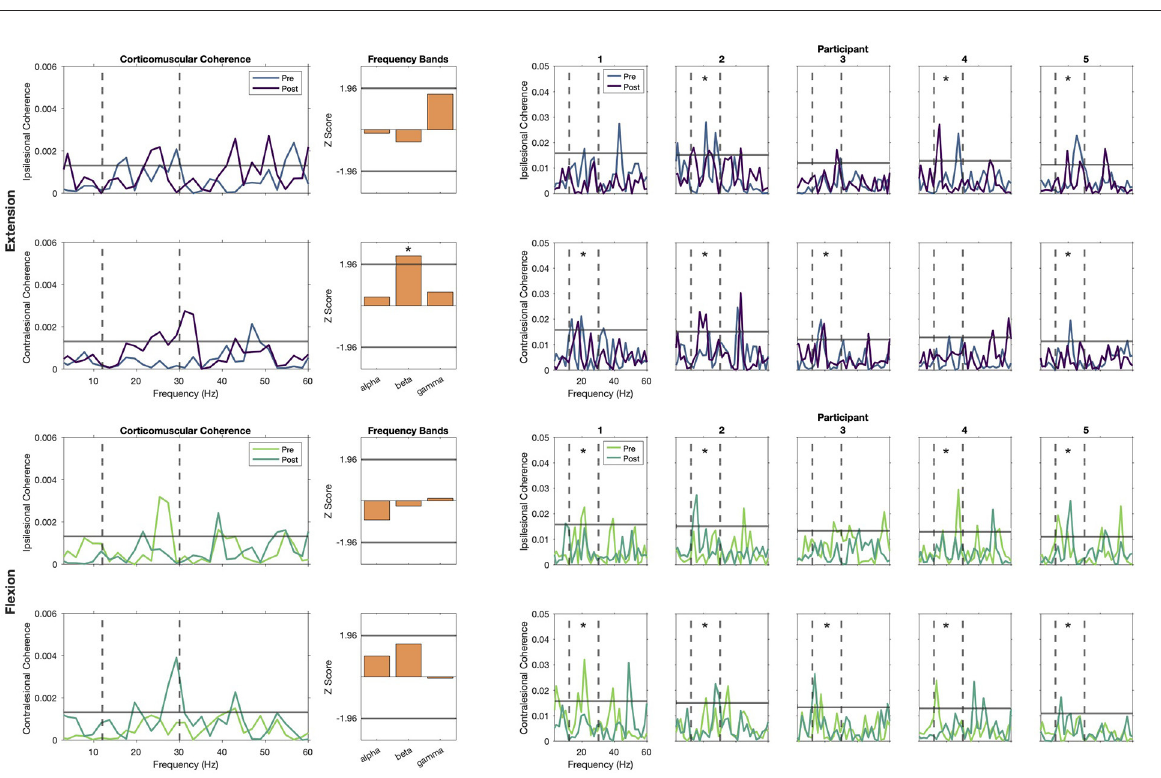
FIGURE4 Corticomuscular coherence (CMC) during static extension and flexion. Left show the group-level pooled coherence for extension (top) and flexion (bottom) tasks, with activity pre-REINVENT in lighter colors and post-REINVENT in darker colors. Note that significant coherence is present during extension (top) before and after training in the beta band at the ipsilesional hemisphere, and that there is a significant increase in the contralesional hemisphere. Similarly, beta band coherence during flexion (bottom) seems to shift from the ipsilesional toward the contralesional hemisphere. Middle show bar plots of pooled-coherence spectra and represent the composite group difference in coherence before vs. after training within alpha (8–12Hz), beta (12–30Hz), and gamma (30–50Hz) frequency bands. Asterisks denote significant changes in a frequency band before vs. after training. Right show individual profiles (Participants 1–5, left to right ) of coherence for extension (top) and flexion (bottom) tasks. Asterisks in individual plots note participants that showed significant CMC in the beta band before or after training. Top rows of each panel show plots for ipsilesional electrodes and bottom rows show contralesional electrodes. Coherence spectra within 0 and 60Hz are shown in all plots, including vertical dashed lines indicating boundaries of the beta band and a solid horizontal line to indicate significant